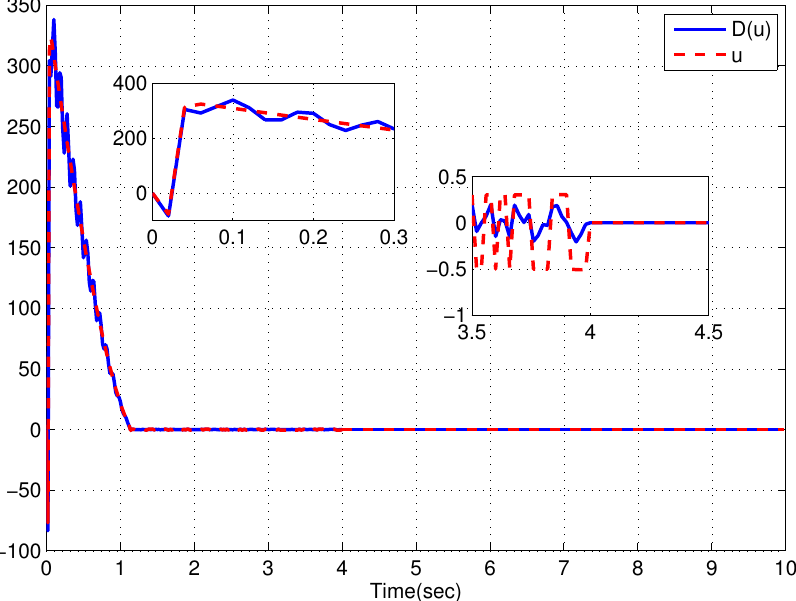
Figure 5. The input responses of the CLS with initial condition ( z 1 ( 0 ) , z 2 ( 0 )) = ( 5, − 10 ) . To text the robustness of the proposed controller, the external disturbance ω ( t ) = 0.1 sin t is introduced in the input channel. With the same parameters, the re- sponses of the CLS are given in Figures 6 and 7, from which it is observed that the proposed controller is robust against small external